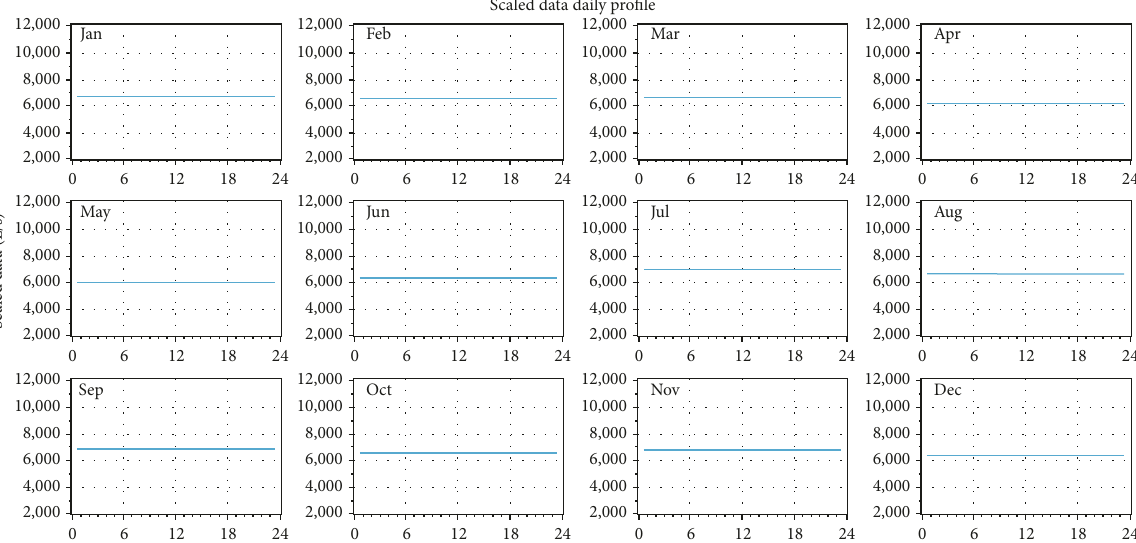
Figure 14: Details of flow rates of every month at the Ancol Bligo irrigation canal, Magelang, Central Java.